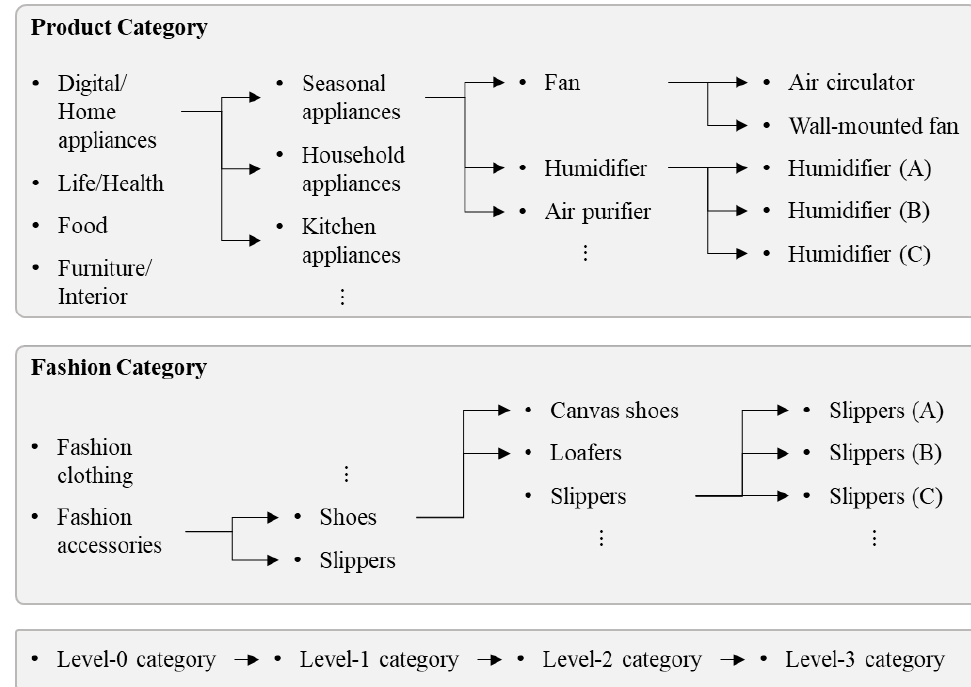
Figure 3. An example of the hierarchical categories of